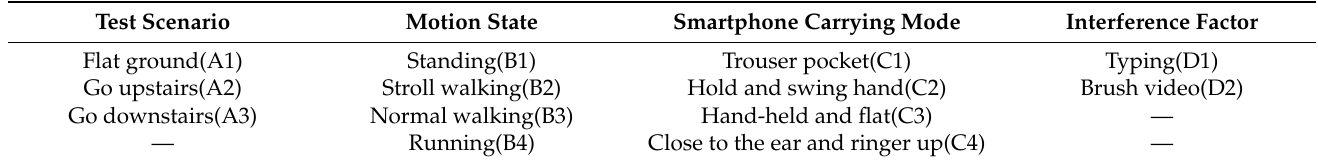
Table 2. Experimental motion environment, motion state, smartphone carrying mode and interfer- ence factor.